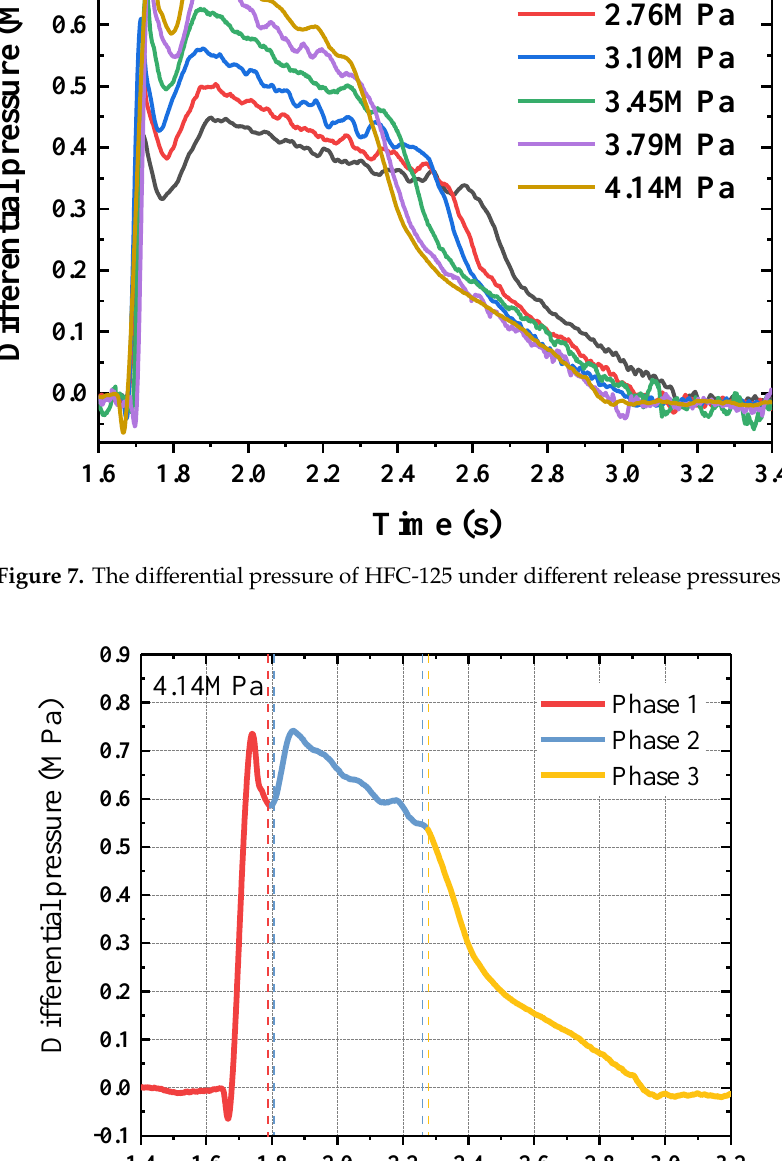
ff erential pressure curve in the pipeline at 4.14 Figure 8. Phase division determined by the differential pressure curve in the pipeline at 4.14 MPa. Figure 8. Phase division determined by the di